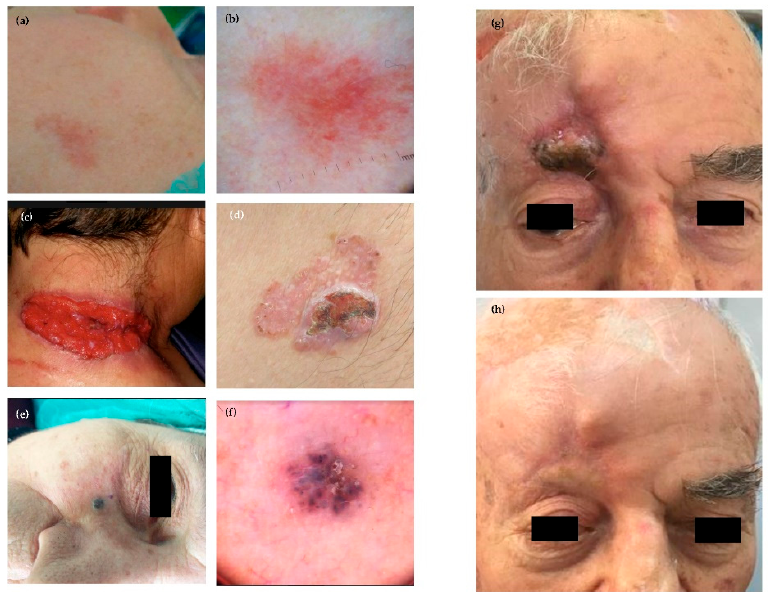
Figure 1. Representative clinical patterns and dermatoscopy of BCCs: ( a ) clinical features and ( b ) dermatoscopy of superficial BCC of the cheek; ( c ) ulcerated and ( d ) multifocal BCC; ( e ) nodular pigmented BCC of the zigomatic area and ( f ) relative pattern by dermatoscopy; and ( g , h ) Effect of Hedgehog inhibitors in a patient with advanced BCC of the head.